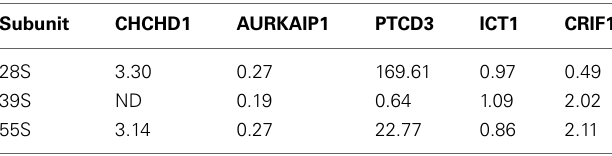
Peptides (ion score cut off of ≥ 45) listed in Table S3 were used in emPAI calculations. ND; not detected.